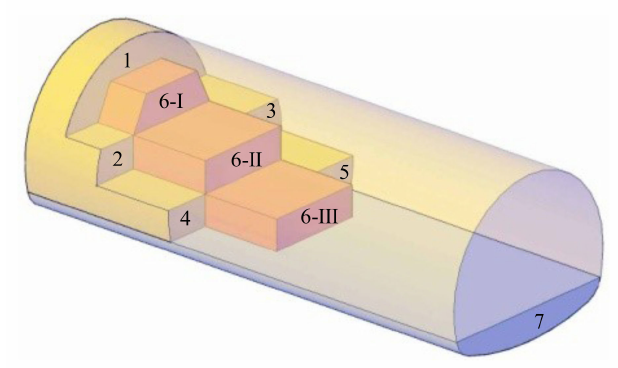
Figure 6. Construction steps in the tunnel.